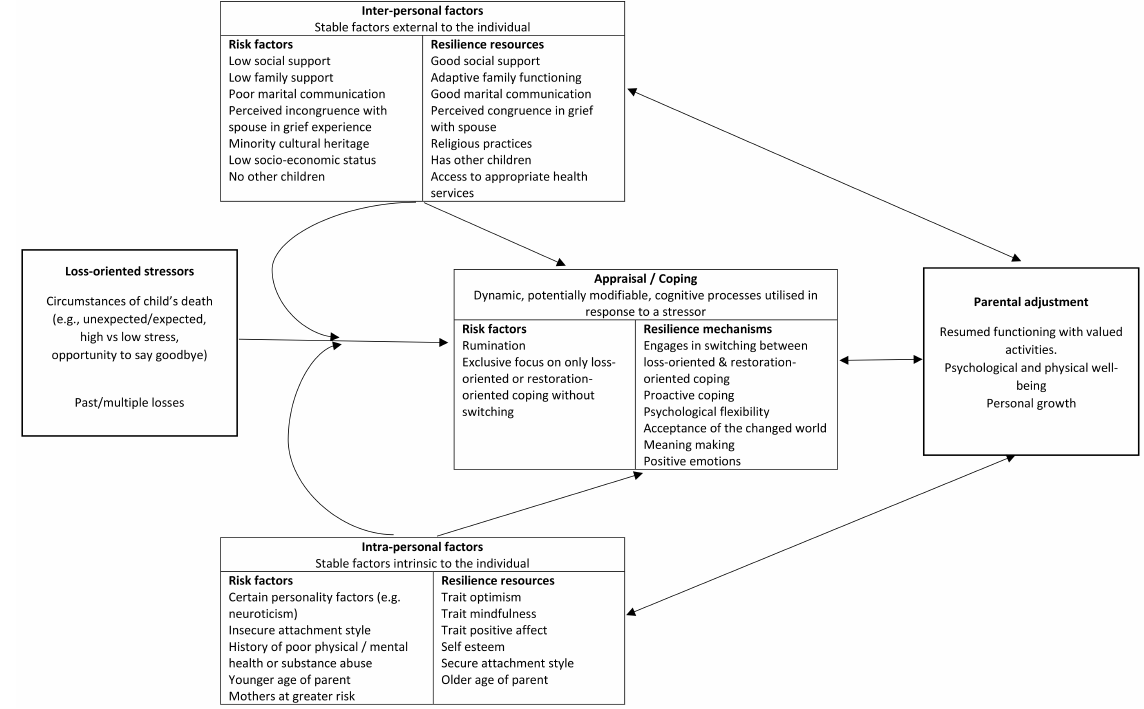
Figure 1. Risk and Resilience Model of Parental